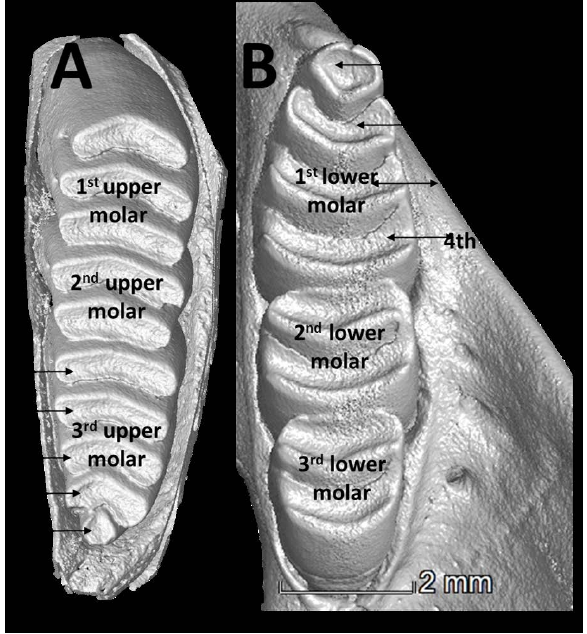
Figure 1: Terminology used for the upper and lower laminate molar teeth of vlei rats ( Otomys sp.): (A) right maxillary tooth row of O. sloggetti and (B) right mandibular tooth row of O. sloggetti (Ditsong National Museum specimen